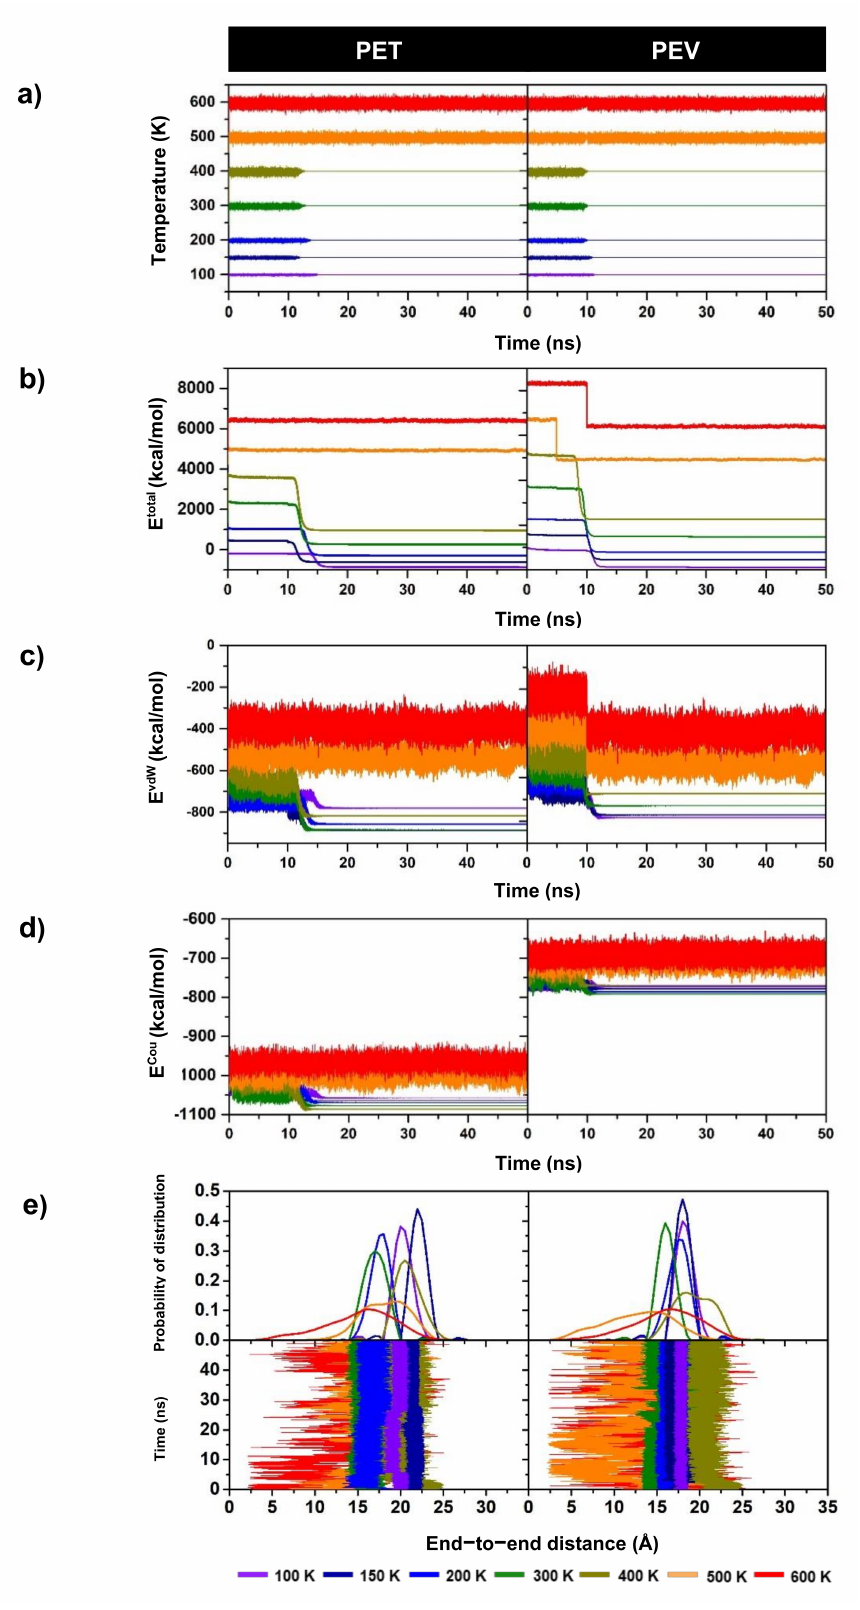
Figure 4. The plots of ( a ) temperature, ( b ) total energy (E tot ), ( c ) Van der Waals energy (E vdW ), ( d ) Coulombic energy (E Cou ), and ( e ) end-to-end distance and its probability distribution for single- chain polymers PET and PEV along the simulation time at temperatures 100–600